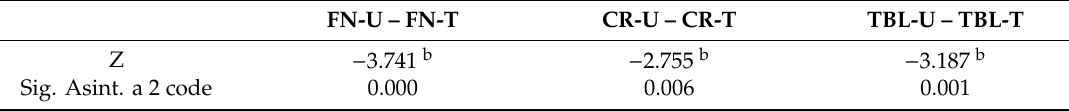
Table 5. Output of Wilcoxon test. a. Wilcoxon test. b. Based on negative ranks.